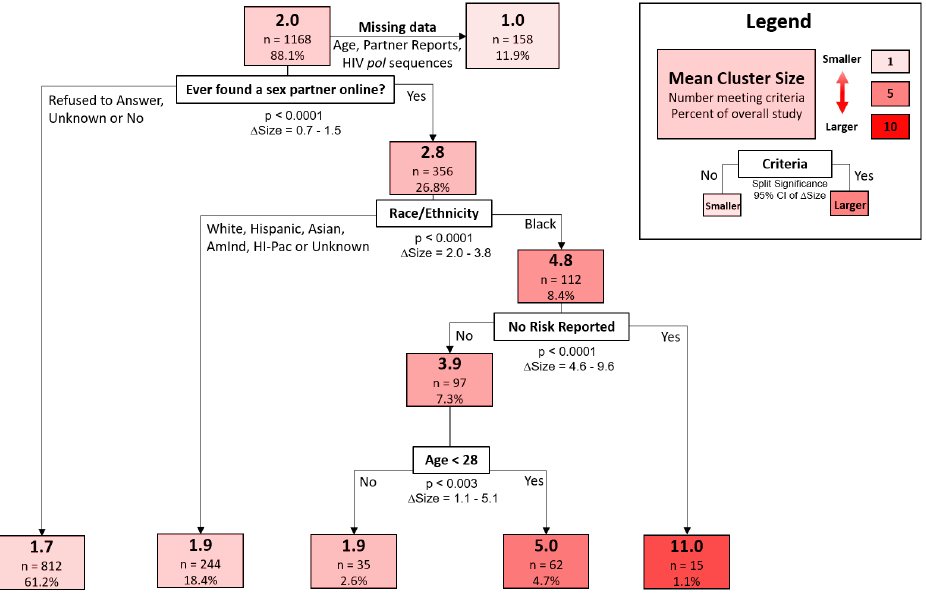
Figure 4. An example decision tree from the random forest model, trained to differentiate participants by cluster size based on their demographic and behavioral risk characteristics. Each colored box represents the number of participants meeting preceding criteria. Each box displays the mean cluster size, number of participants and their overall prevalence in the data. The criteria, statistical significance and confidence intervals of the difference in mean cluster size (∆Size) are displayed below each branching point of the tree.